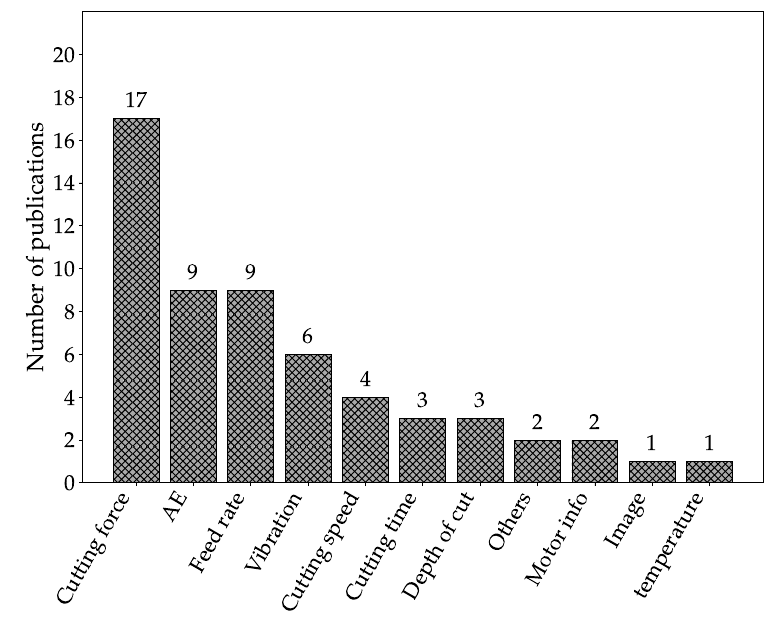
Figure 12. Repartition of inputs for fuzzy